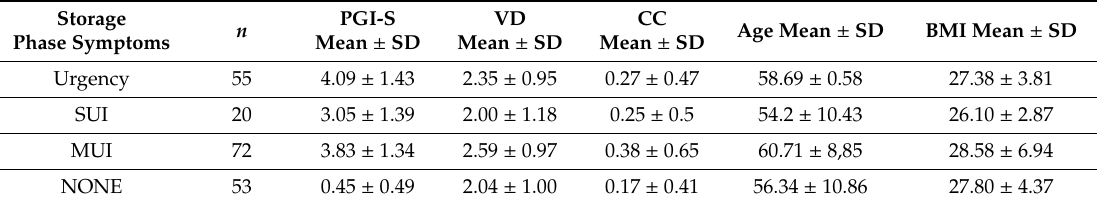
Table 1. Patients demographic depending on concomitant dominant storage phase disorders of the lower urinary tract -based on the Lower Urinary Tract Symptoms (LUTS) survey.